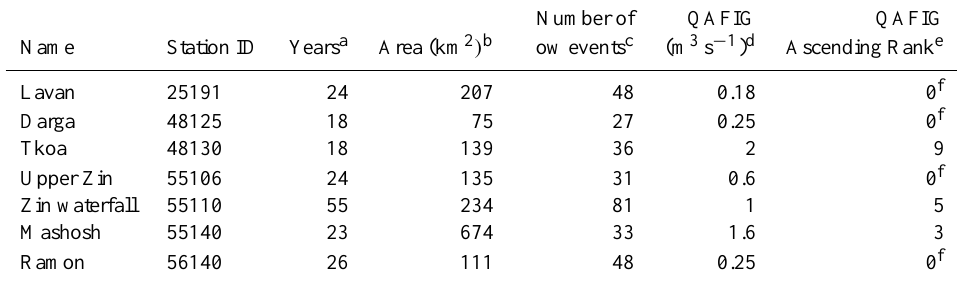
Table 5. Summary of data from the hydrometric stations that are collocated with surveyed cross sections.